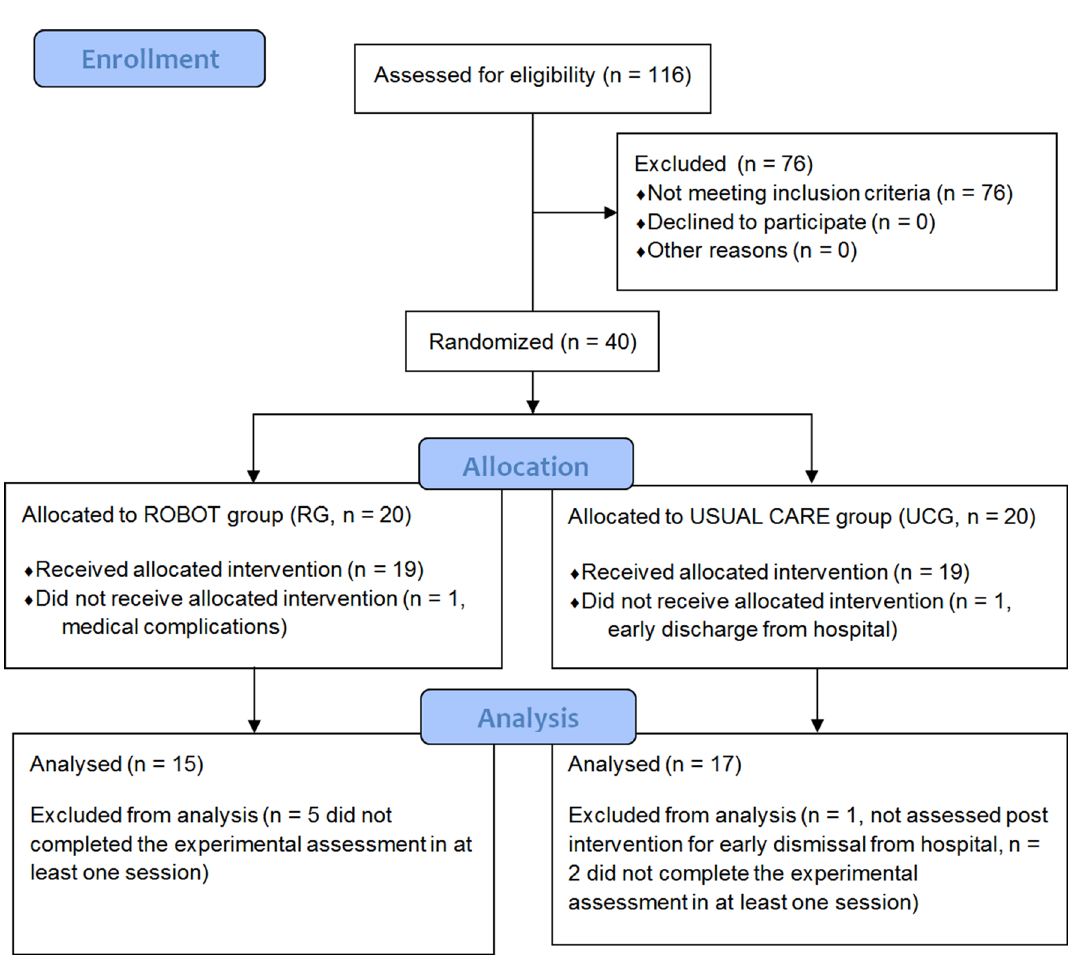
Figure 1. Flow chart of the